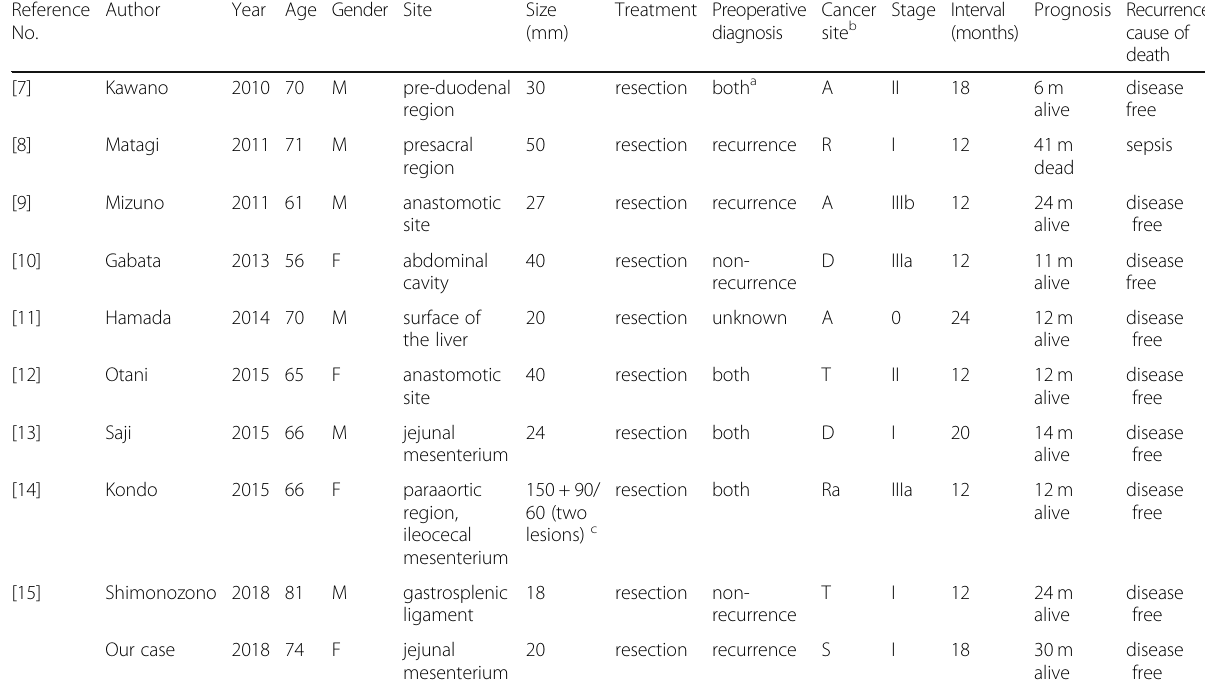
Table 1 Reference